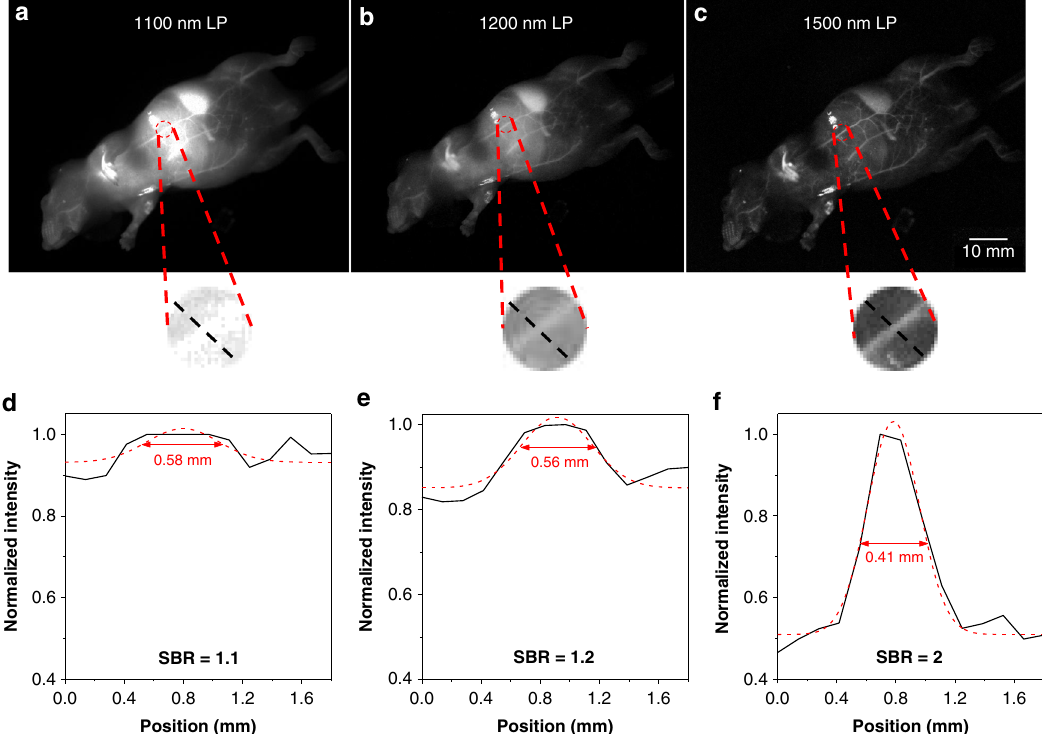
Fig. 5 Comparison of NIR-II fl uorescence signals for whole-body imaging of living mice in an area close to the liver under different LP fi lters treated with 2TT- o C26B NPs (200 μ L, 0.8 mg/mL). a 1100 nm LP, 5 ms, 37 mW/cm 2 ; b 1200 nm LP, 5 ms, 37 mW/cm 2 ; c 1500 nm LP, 150 ms, 75 mW/cm 2 . d – f Corresponding cross-sectional fl uorescence intensity pro fi les along black-dashed lines. Gaussian fi ts the pro fi le are shown in the red